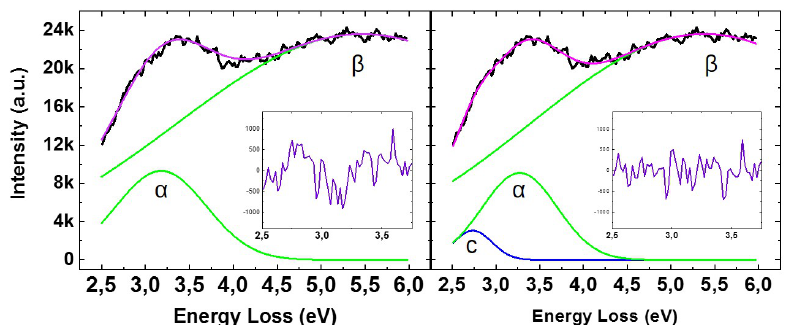
Figure A3. Comparison of a double and triple Gaussian fit on the 2.5–6 eV energy window for an EEL spectra. Inset: Residuals from the Gaussian fit.